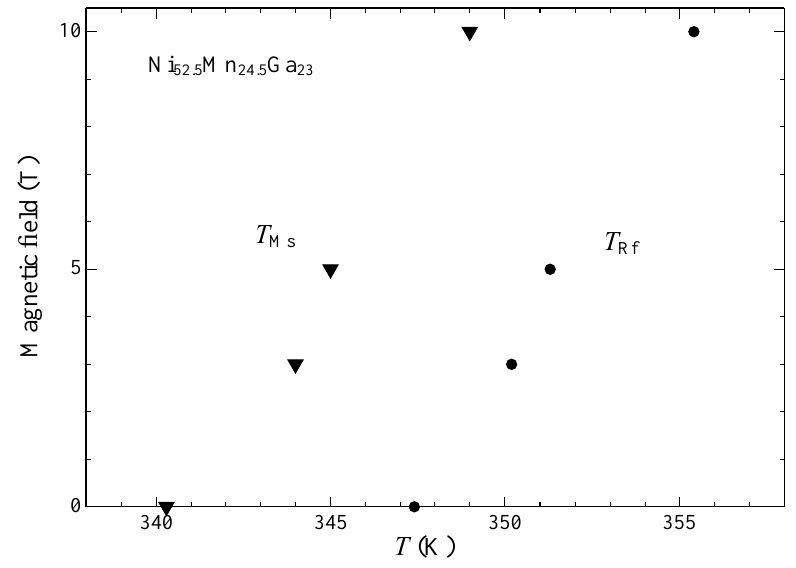
Figure 4. Magnetic phase diagram of Ni martensite transition start temperature T finishing temperature T